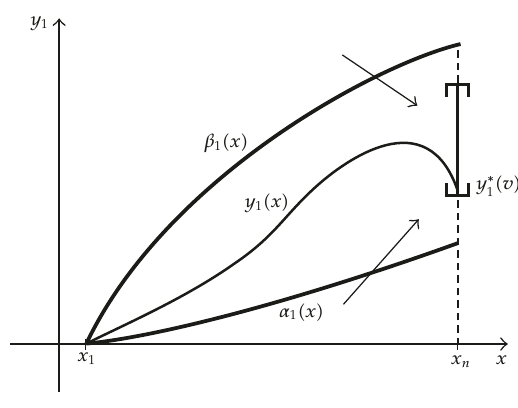
Figure 1: Using Lemma 5.1.